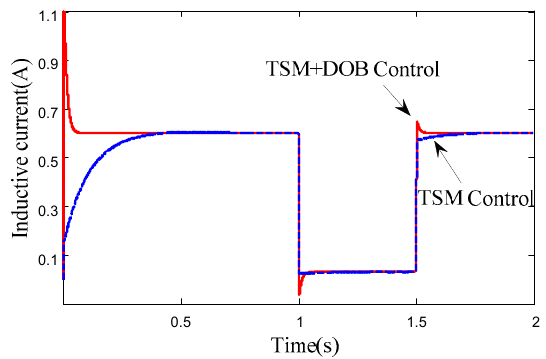
Figure 5. Simulated step ‐ load waveform of the inductive current.